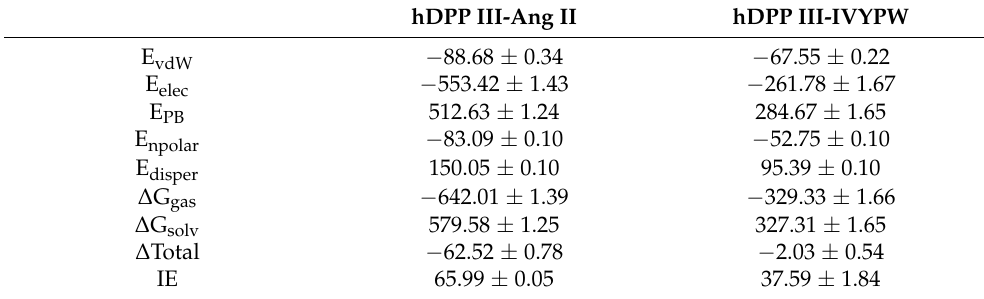
Table 4. MM/PBSA and interaction entropy results for two enzyme–ligand systems